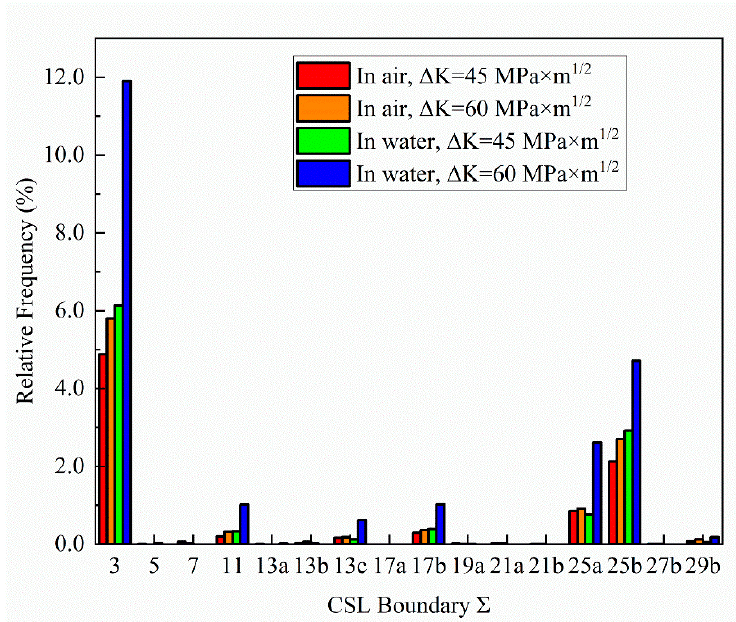
Figure 14. CSL boundary distribution in X80 steel welded joints.